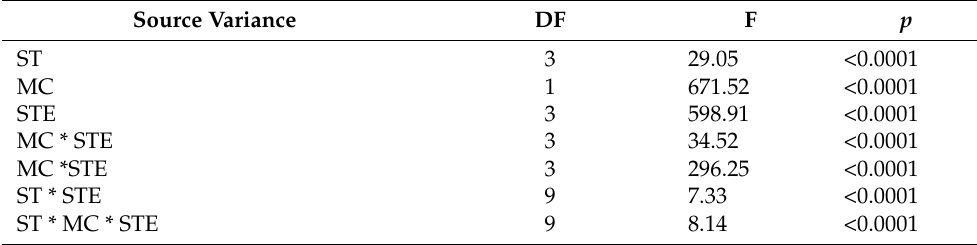
Table 1. Analysis of variance (ANOVA) of the effect of storage time (0, 1, 2, 3 years), moisture content (7, 13%), and temperature of storage (3, − 3, − 10, − 20 ◦ C) on total m 5 C level of embryonic axes of Fagus sylvatica L. ST, storage time; STE, storage temperature; MC, moisture content. Source Variance MC * STE